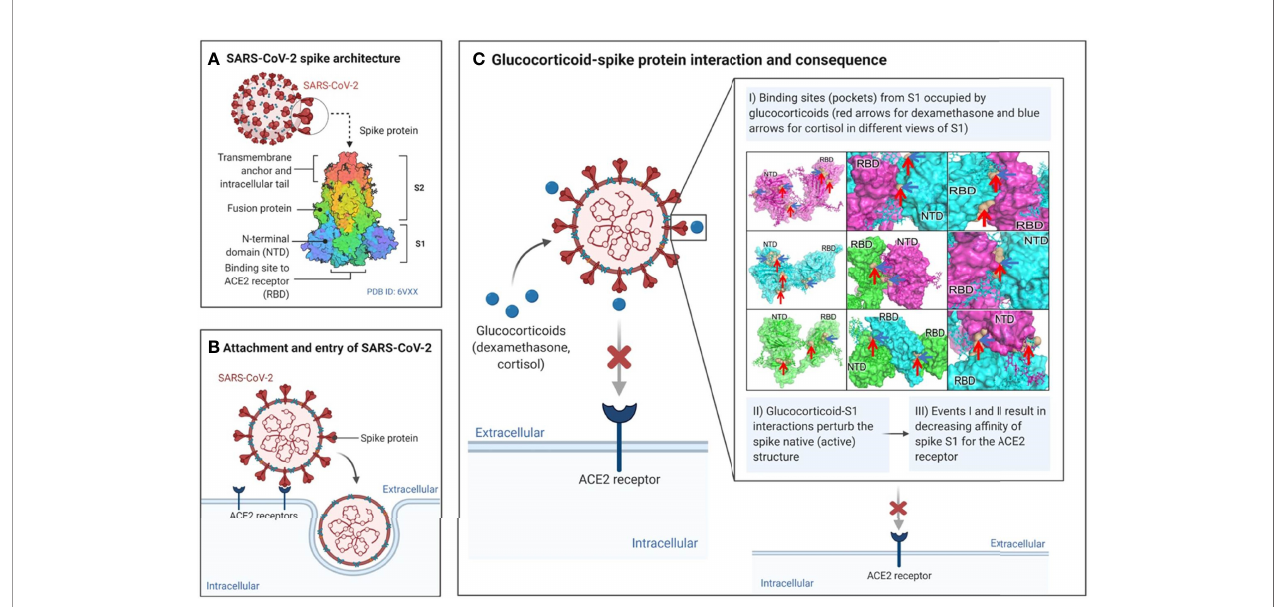
FIGURE 7 | Summary of proposed mode of action of glucocorticoids in directly affecting SARS-CoV-2 – ACE2